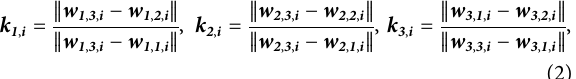
FIGURE 4 Scanning trajectory overview. (A) In the quantitative phantom. (B) In the leg of a volunteer. The scanning trajectories are depicted with dashed